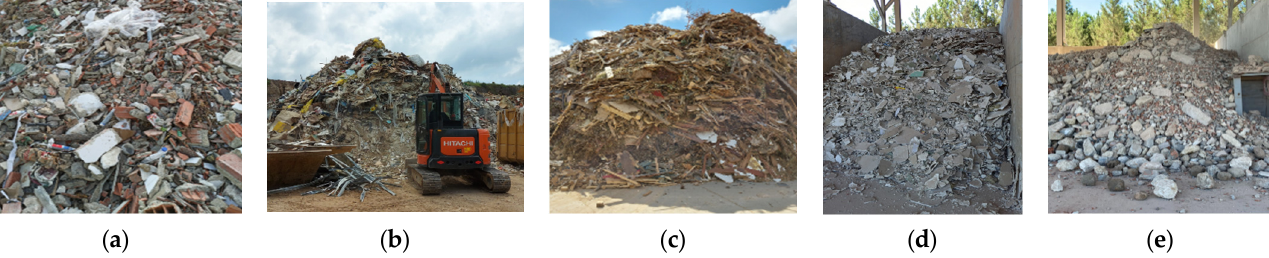
Figure 1. Separation of CDW by type( a ) CDW requiring separation ( b ) Ongoing separation ( c ) Wood waste ( d ) Plasterboard waste ( e ) CDW—suitable.